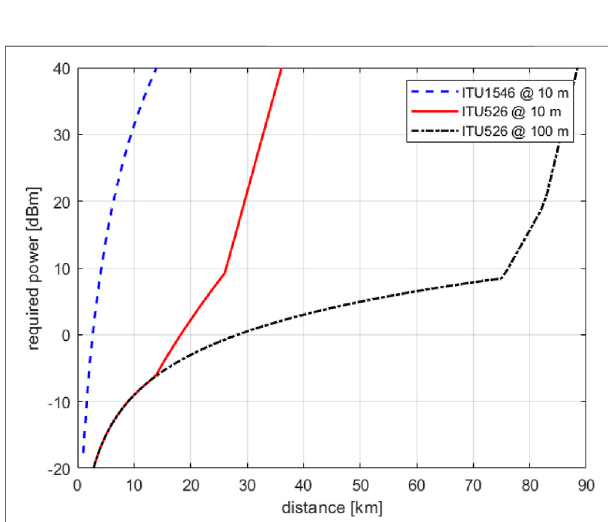
FIGURE4| RequiredPApower at 5 GHzcarrier frequency asafunction of link distance with 40 MHz bandwidth and QPSK modulation with 1/2-rate coding.